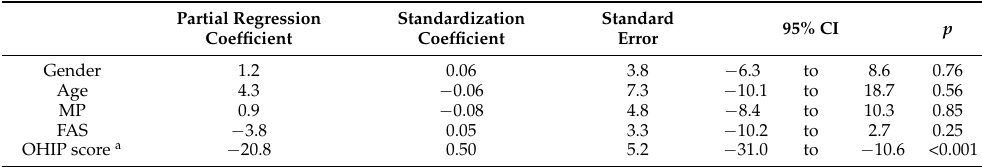
Table 6. Result of the multiple linear regression